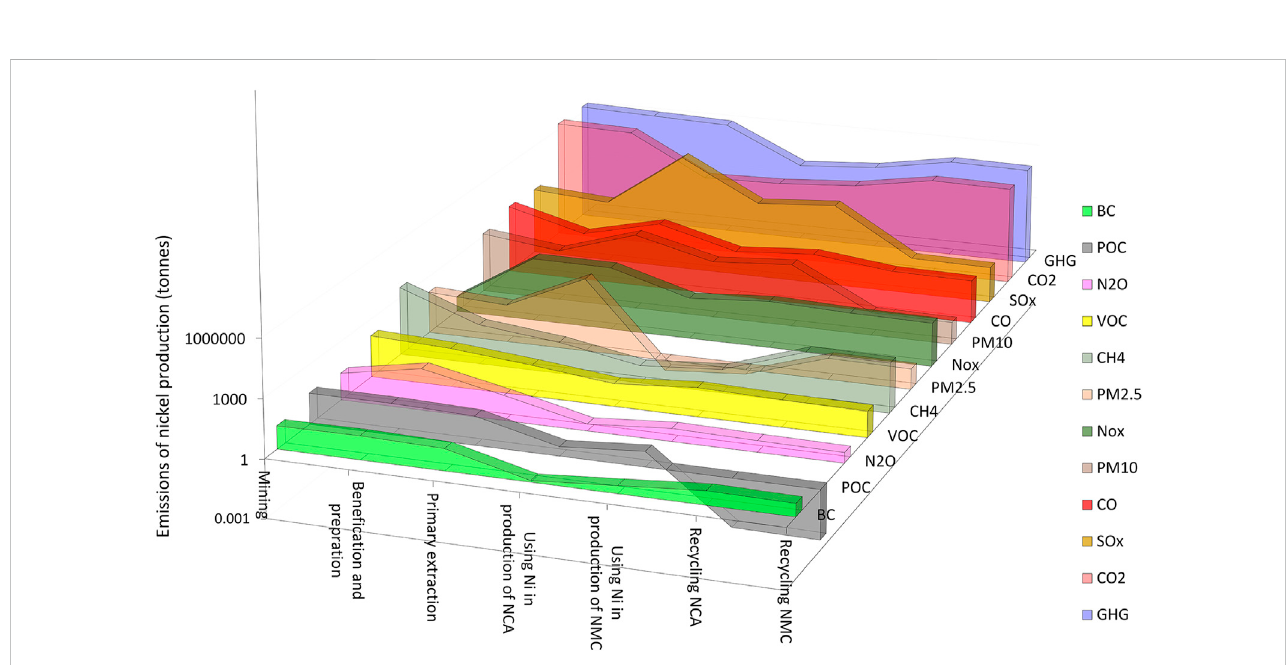
FIGURE 4 Estimated emissions generated by nickel production by